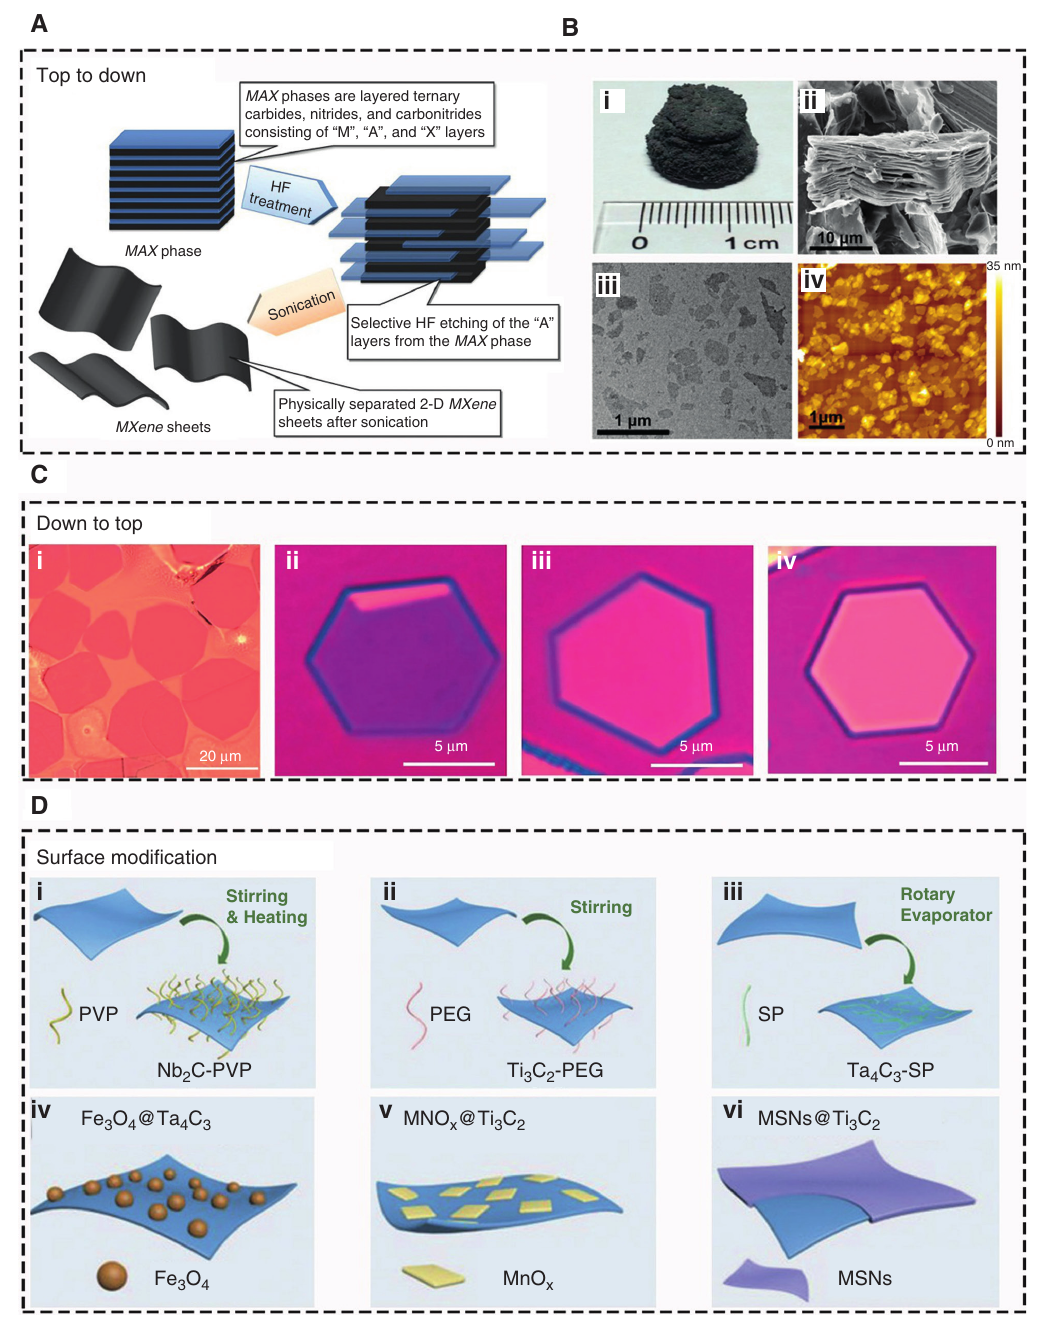
Figure 2: MXene preparation and surface modification